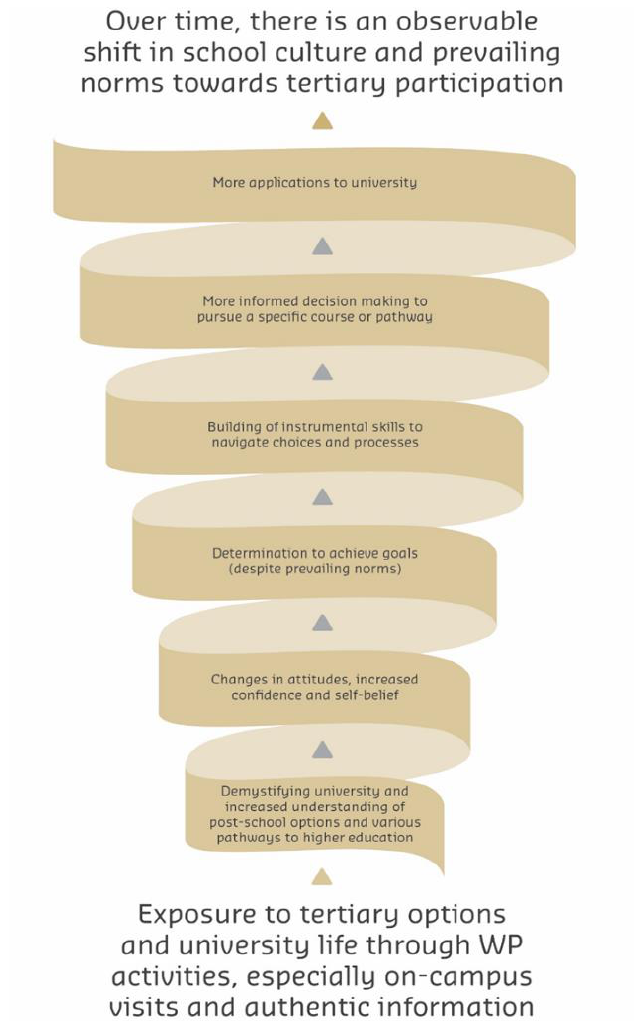
Virtuous Circle of Sustained Widening Participation Activity in Highly Engaged